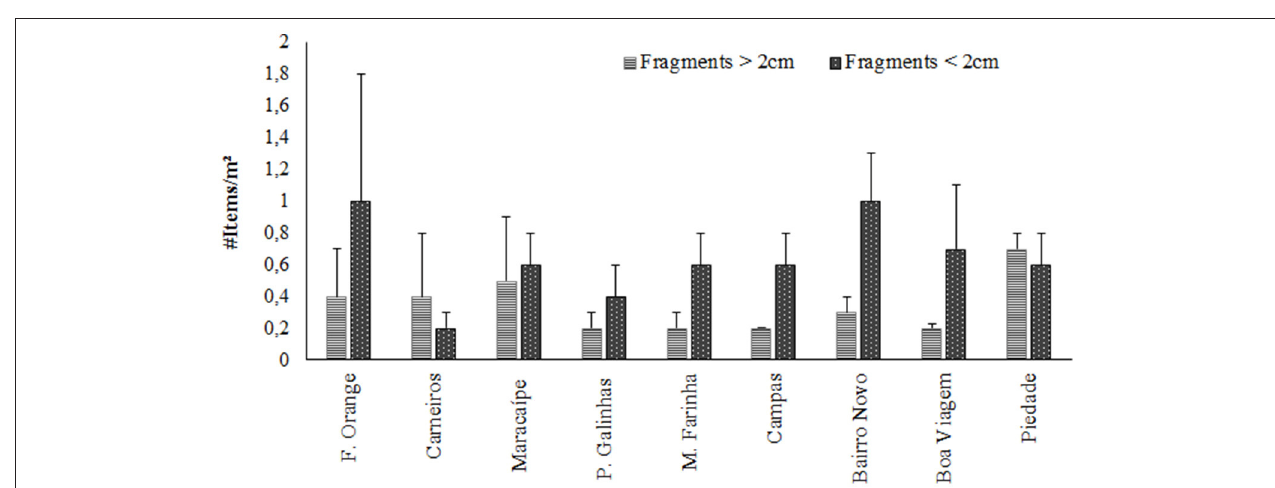
FIGURE 6 | Mean number and standard deviation of plastic fragments found on the strandline at the evaluated